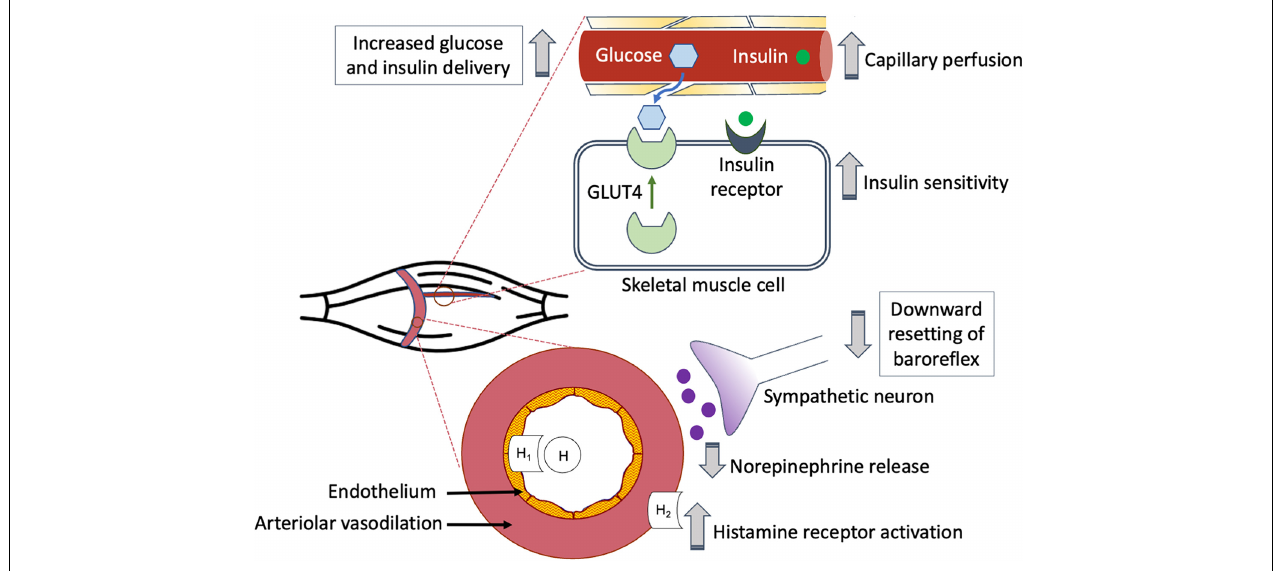
FIGURE 1 | Post-exercise hyperemia facilitates glucose delivery to previously active skeletal